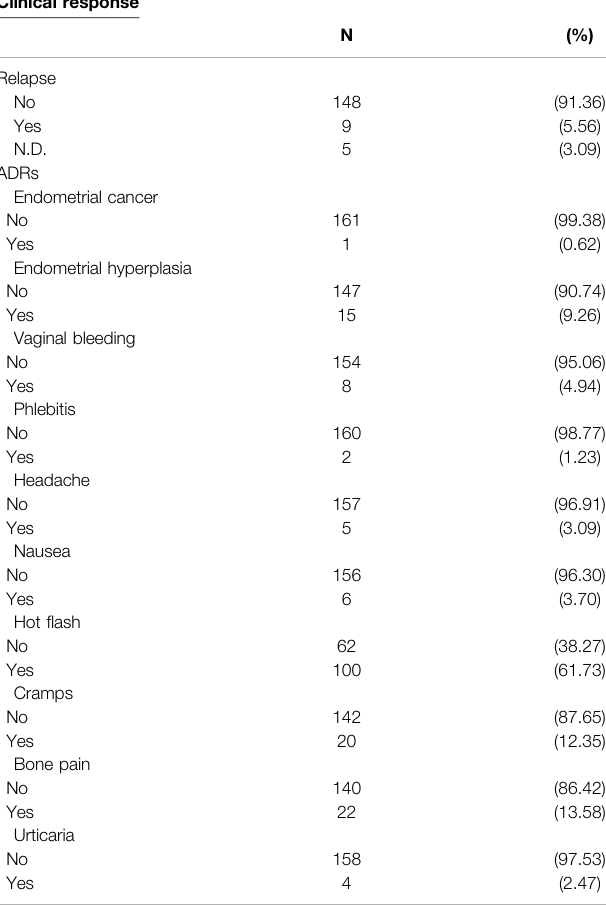
TABLE 2 | Relapse and Adverse drug reactions (ADRs) in patients. Clinical response